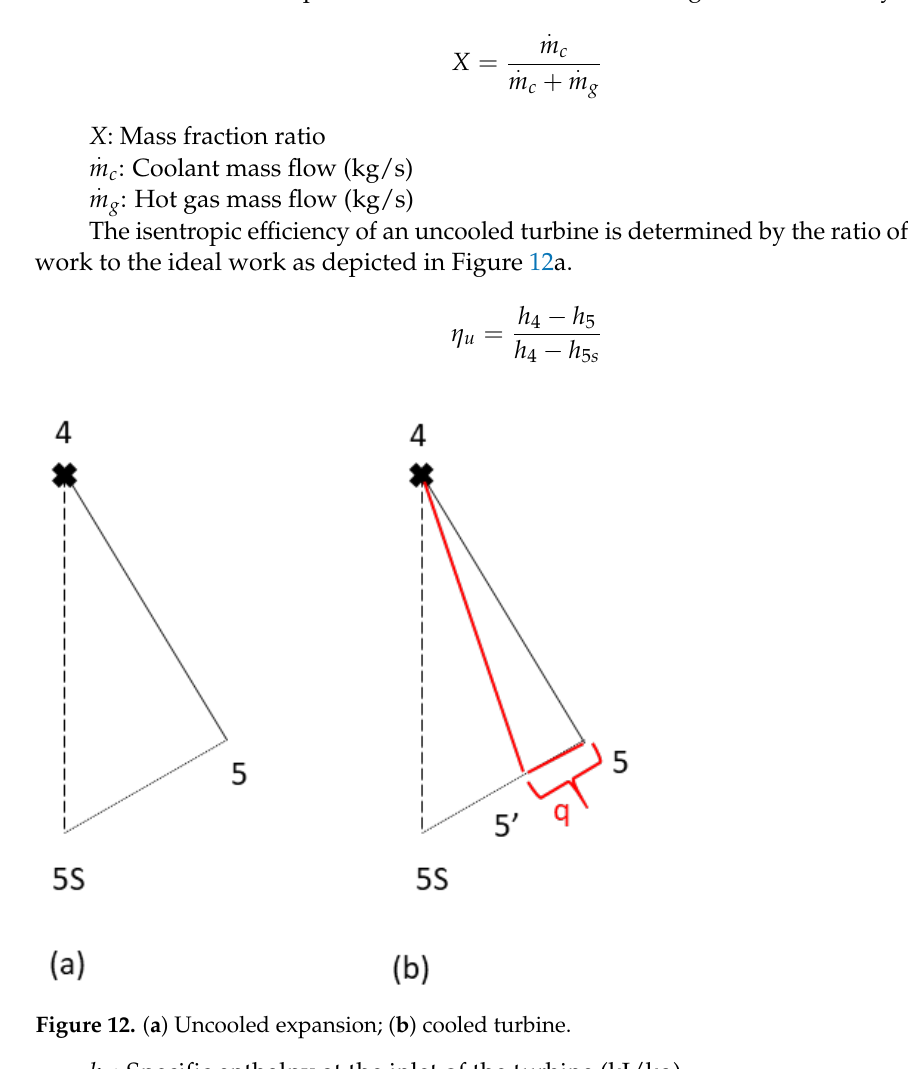
Figure 11. Schematic presentation of the HP cooled turbine as a heat exchanger.